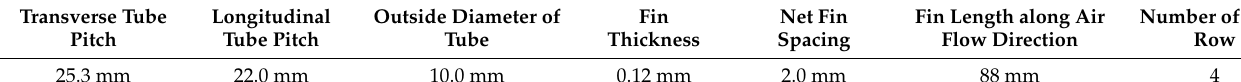
Table 1. Structural parameters of the three test specimens.